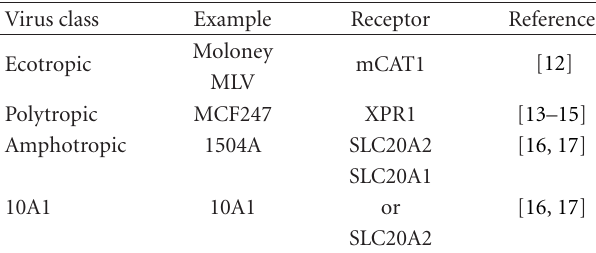
Table 1: MLV receptors on NIH/3T3 mouse